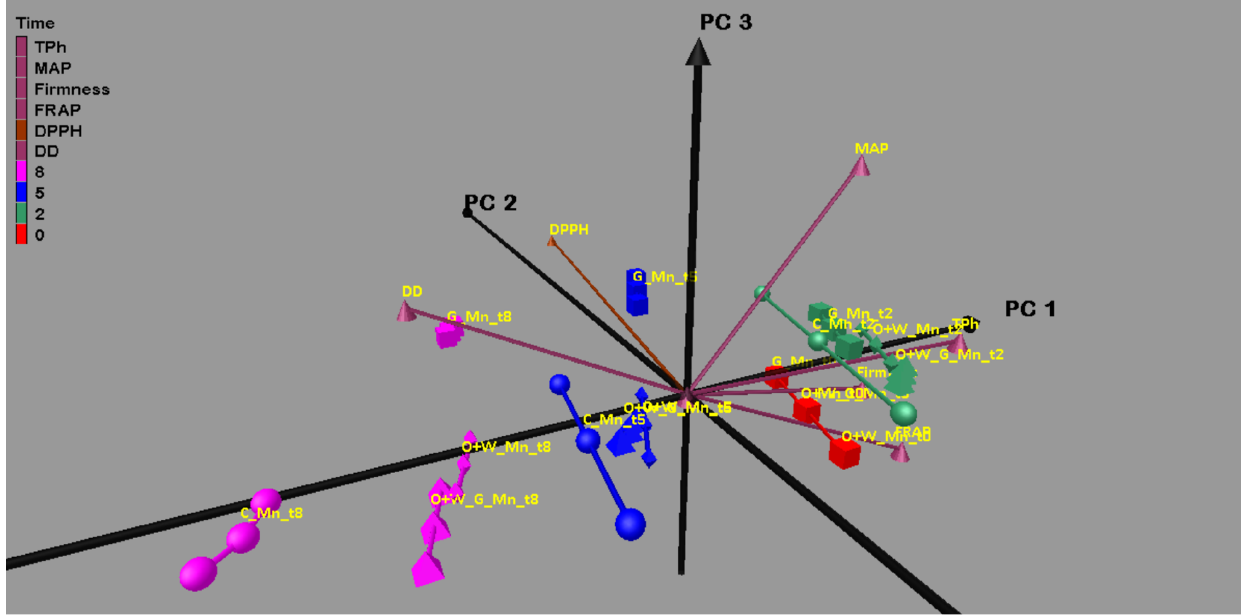
Figure 7. Three-dimensional principal component analysis of the variables (DD, firmness, TPh, MAP, FRAP and DPPH) during cold storage on the first day (t0, red colour) and after two days (t2, green colour), five days (t5, blue colour) and eight days (t8, pink colour) for uncoated (C_Mn) and coated mulberry samples (G_Mn, O+W_Mn, O+W_G_Mn).